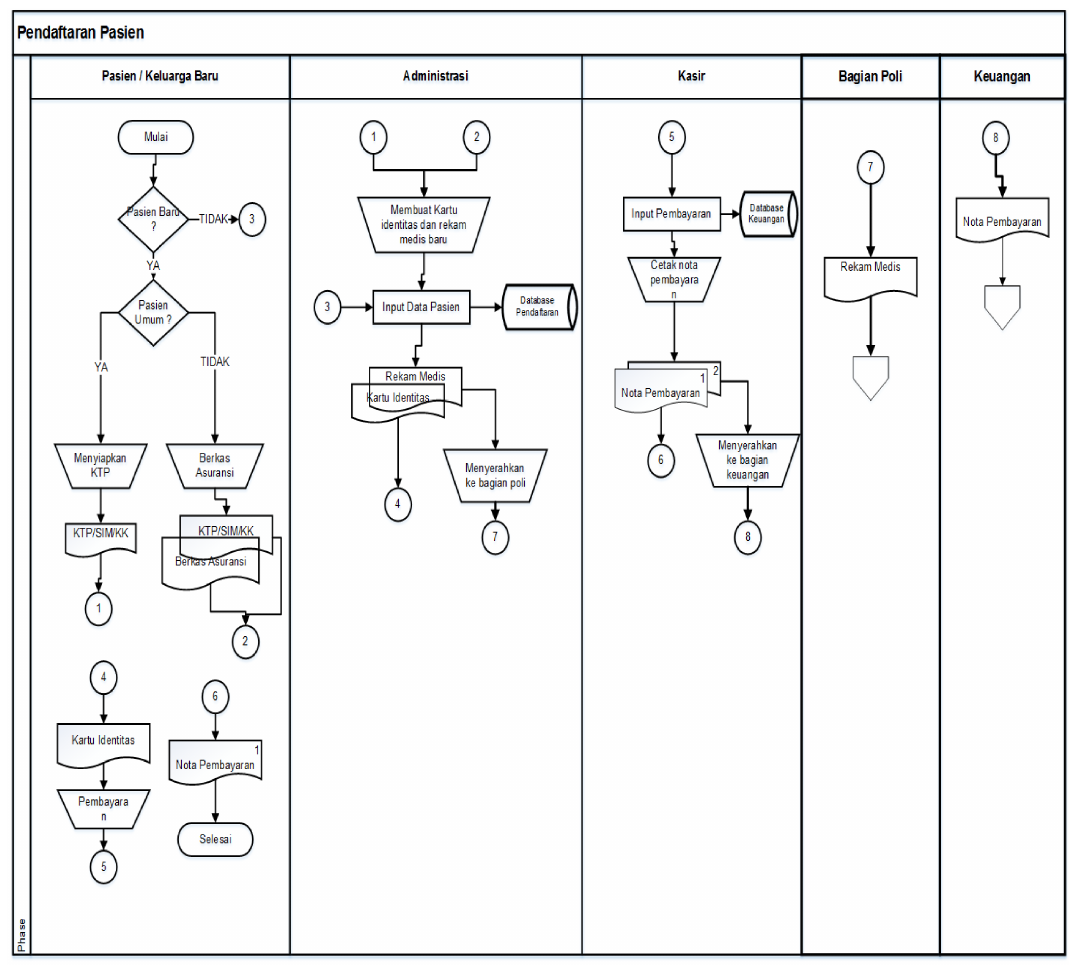
Gambar 1. Diagram Alir Dokumen Proses Pendaftaran T ABEL 6 D AFTAR K ANDIDAT T